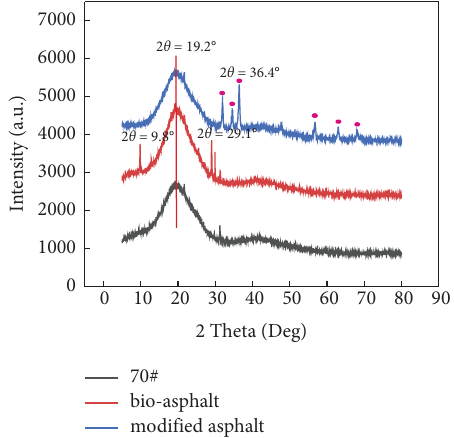
Figure 3: XRD patterns of three kinds of asphalt.